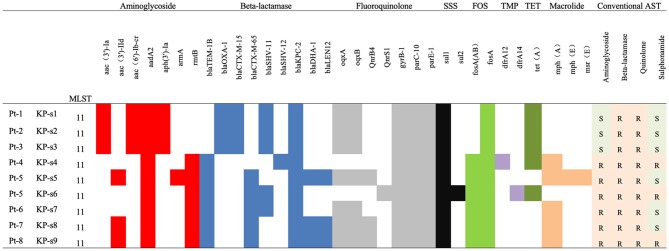
Antibiotic susceptibility and characterization of AR genes among CP-Kp isolates. SSS, Sulphonamides; FOS, Fosmycin; TMP, Trimethoprim; TET, Tetracycline.